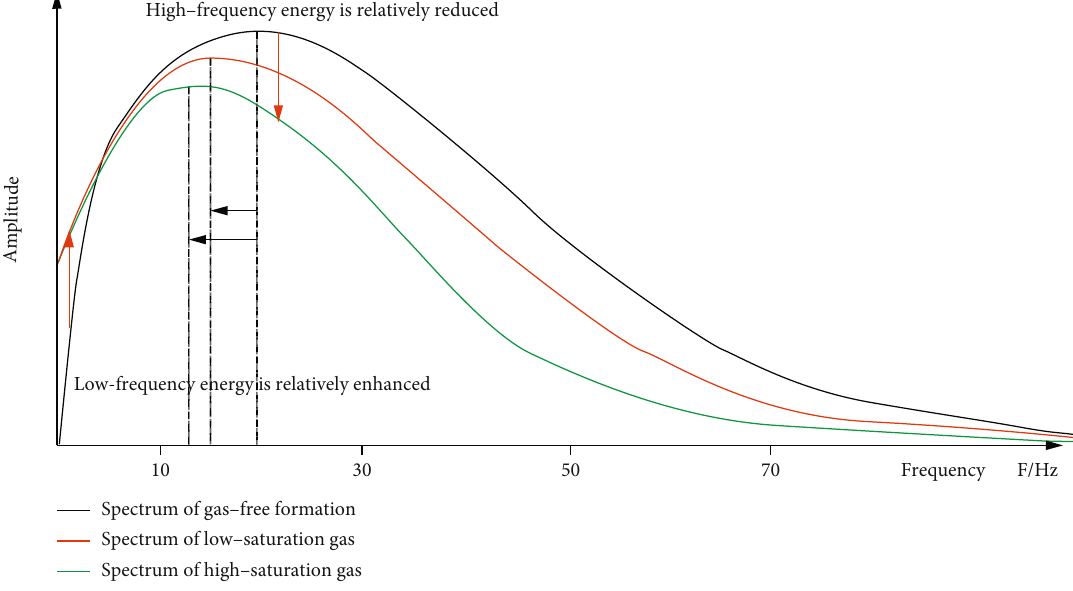
Figure 3: Comparison of frequency spectrum between gas-bearing stratum and nongas